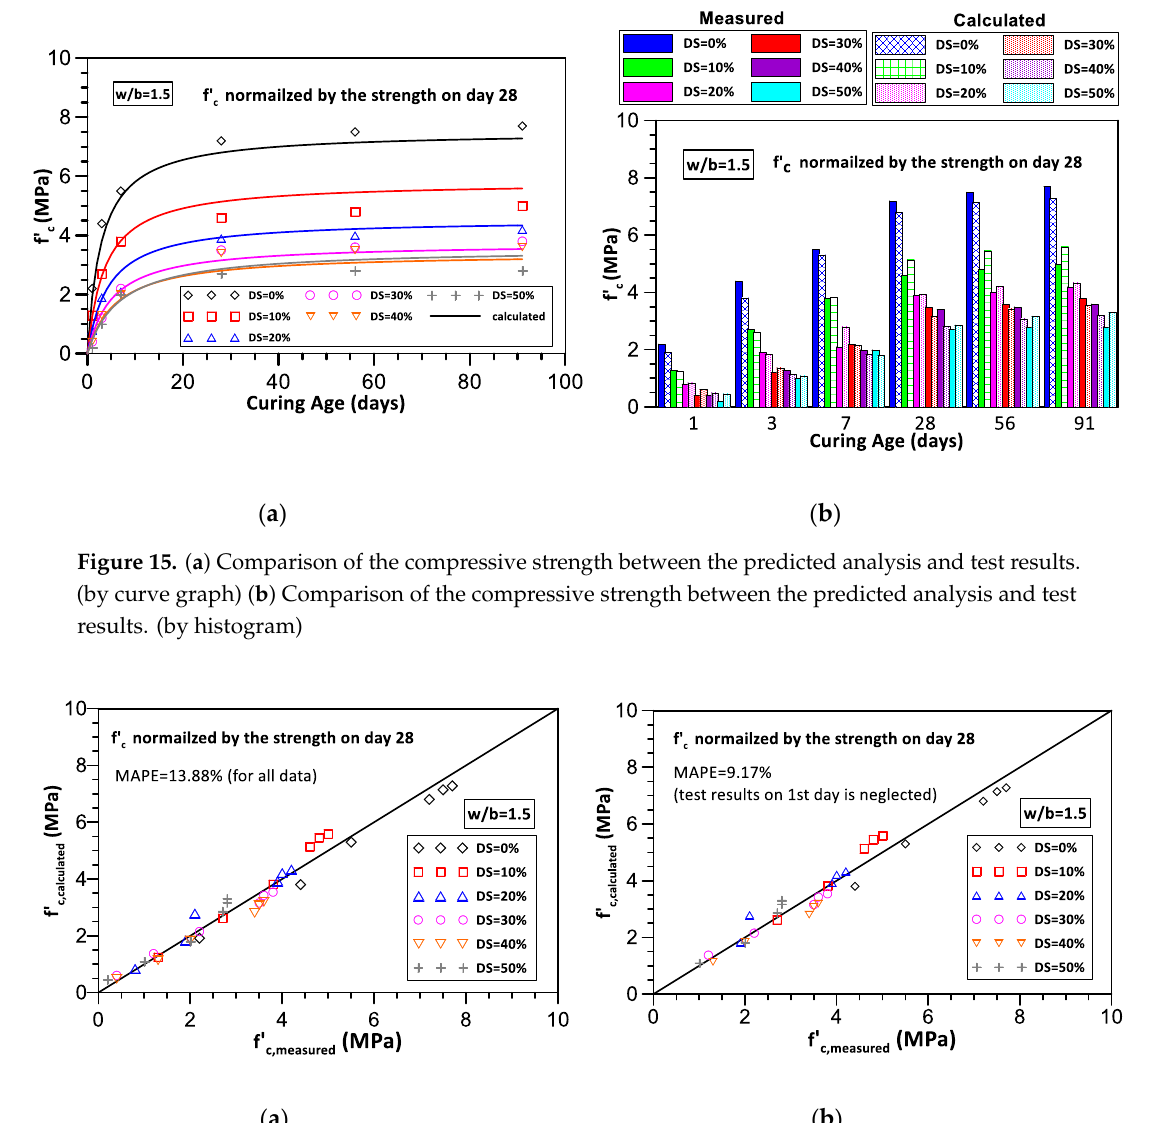
Figure 15. ( a ) Comparison of the compressive strength between the predicted analysis and test results. (by curve graph) ( b ) Comparison of the compressive strength between the predicted analysis and test results. (by histogram)